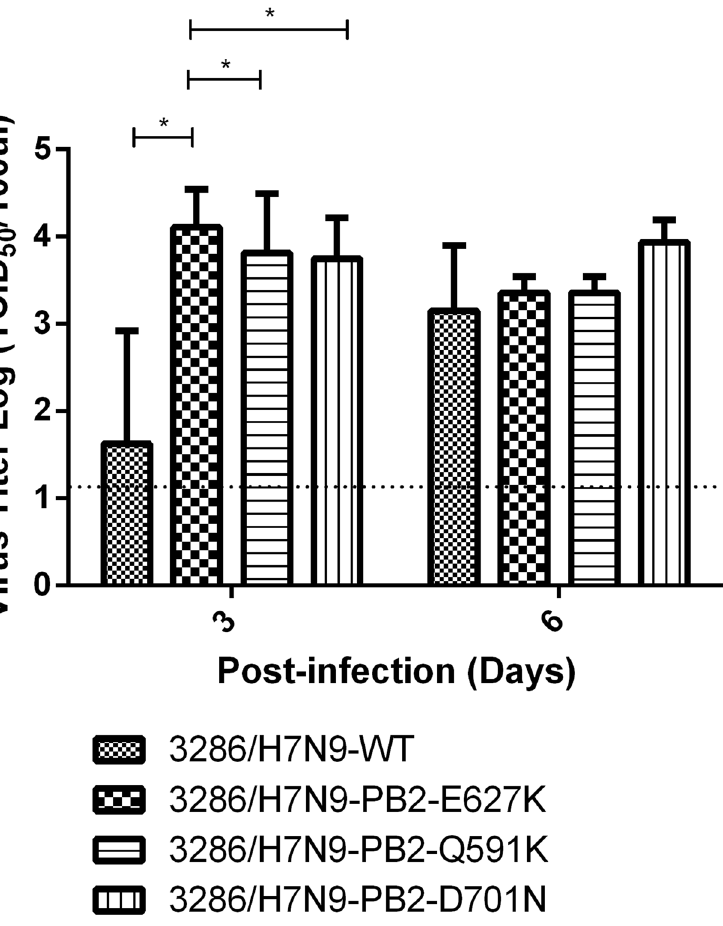
Figure 5. Lung virus titers of mice infected with duck 3286/H7N9 and its PB2 mutants. BALB/c mice were infected with the indicated viruses at 1 × 10 5 PFU. Infected mice were sacrificed on 3 and 6 days post-infection, and virus titers in lung homogenates were measured in MDCK cells. Results from each group and each time point are expressed as mean ± SD of six infected mice from two independent experiments. The values were statistically compared with the wild type 3286/H7N9 using the two tailed, non-paired t-test. * p <